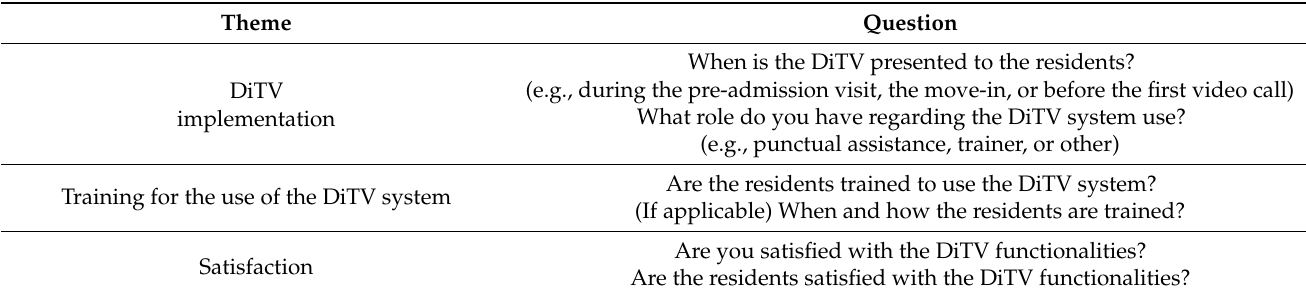
Table 2. Interview guide used for semi-structured interviews with